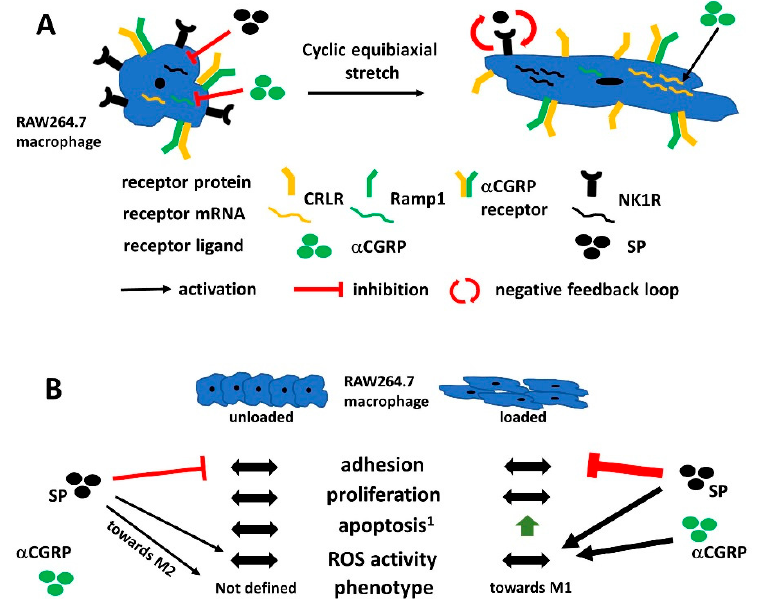
Figure 8. The schematic summary depicting the influence of the cyclic stretch on RAW264.7 macrophage cells in the context of sensory neuropeptide stimulation. ( A ) Physiological stimulation with SP and α CGRP decrease mRNA expression of their respective receptors, NK1R and Ramp1 (an α CGRP-specific subunit of the α CGRP receptor) in unloaded conditions. Cyclic stretch-induced upregulation of mRNA for CRLR (unspecific α CGRP receptor subunit) and NK1R . α CGRP further upregulated the CRLR gene expression resulting in increased CRLR protein expression. Oppositely, albeit upregulation of NK1R mRNA, protein expression decreased, possibly by lack of receptor-ligand SP that was also decreased by cyclic stretch. In loaded RAW264.7 cells, the cyclic stretch might induce a negative feedback loop involving the downregulation of the neuropeptide SP and its respective receptor, NK1R; ( B ) Comparison of cellular traits like adhesion, proliferation, apoptosis, ROS activity and the macrophage phenotype in loaded RAW264.7 macrophages to unloaded controls demonstrated a strong induction of apoptosis and a phenotypic change towards the M1 phenotype. In unloaded cells, SP inhibited adhesion, increased ROS activity and induced the expression of M2 macrophage marker genes. α CGRP effects were marginal. Oppositely, cyclic stretch sensitized macrophages to strong inhibition of adhesion by SP as well as a strong increase in cellular ROS activity by stimulation with SP and α CGRP. 1 The same increase of apoptosis after loading was observed in bone marrow-derived macrophages from mice that underwent surgical OA induction. α CGRP—alpha calcitonin gene-related peptide, CRLR—calcitonin receptor-like receptor, NK1R—neurokinin receptor 1, Ramp1—receptor activity modifying protein 1, SP—substance P, OA - osteoarthritis.